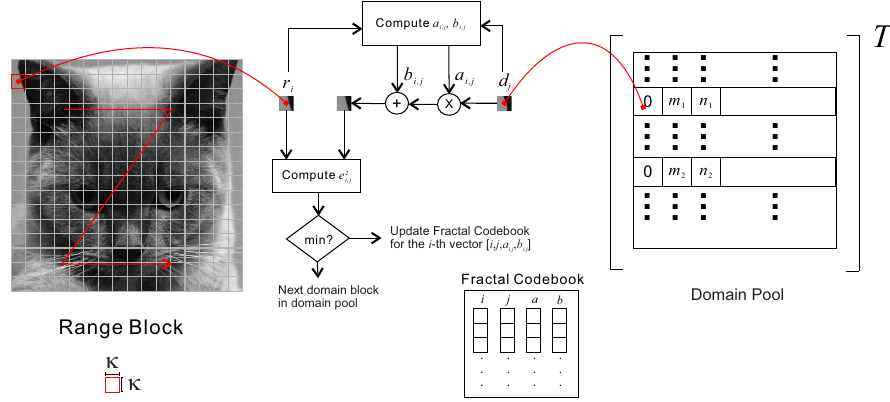
Figure 2. Fractal encoding by matching range blocks with grayscale transformed domain blocks from the domain